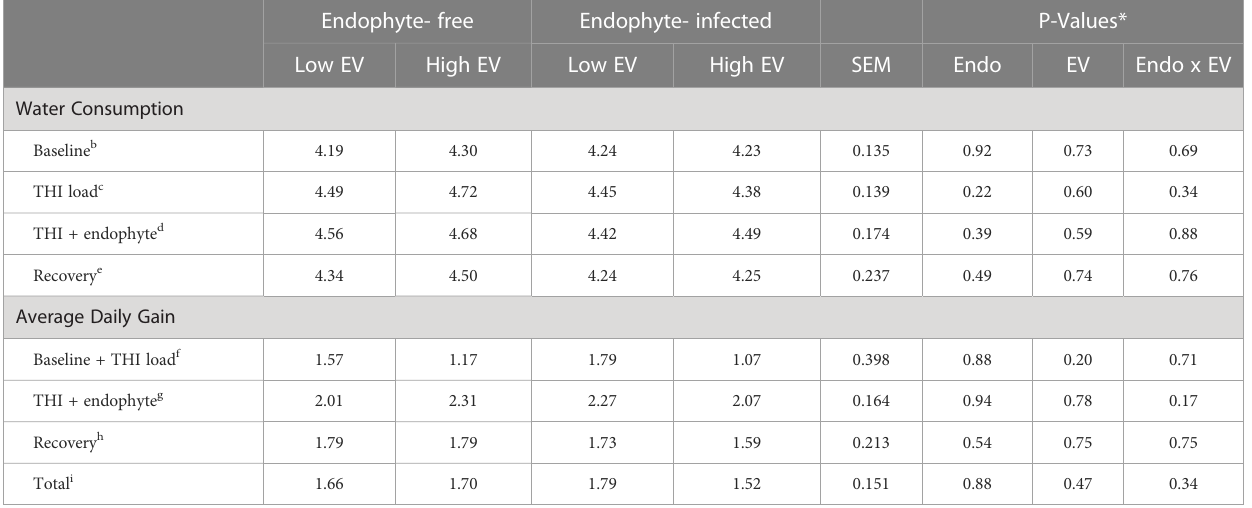
TABLE 4 Experiment 1 water consumption as a proportion of body weight and heifer average daily gain in response to endophyte (Endo) and exit velocity (EV) treatments a .